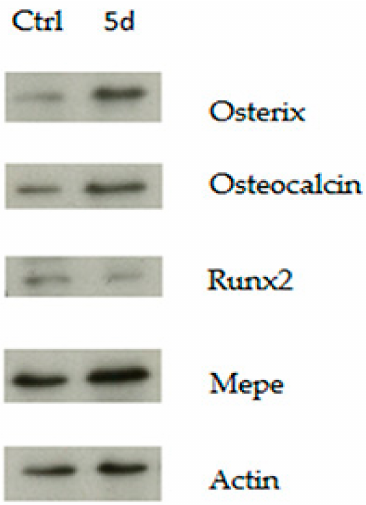
Figure 9. 30 µ g of protein extracts derived from 2T3 osteoblasts maintained in cycling (Ctrl) and differentiating condition (5d) for 5 days were separated in SDS-PAGE and the indicated proteins were revealed by immunoblotting.